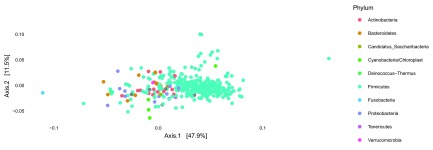
Species coordinates that can be used to interpret the sample positions from PCoA with weighted Unifrac.Compared to the representation in
Figure 12, this display is harder to interpret.